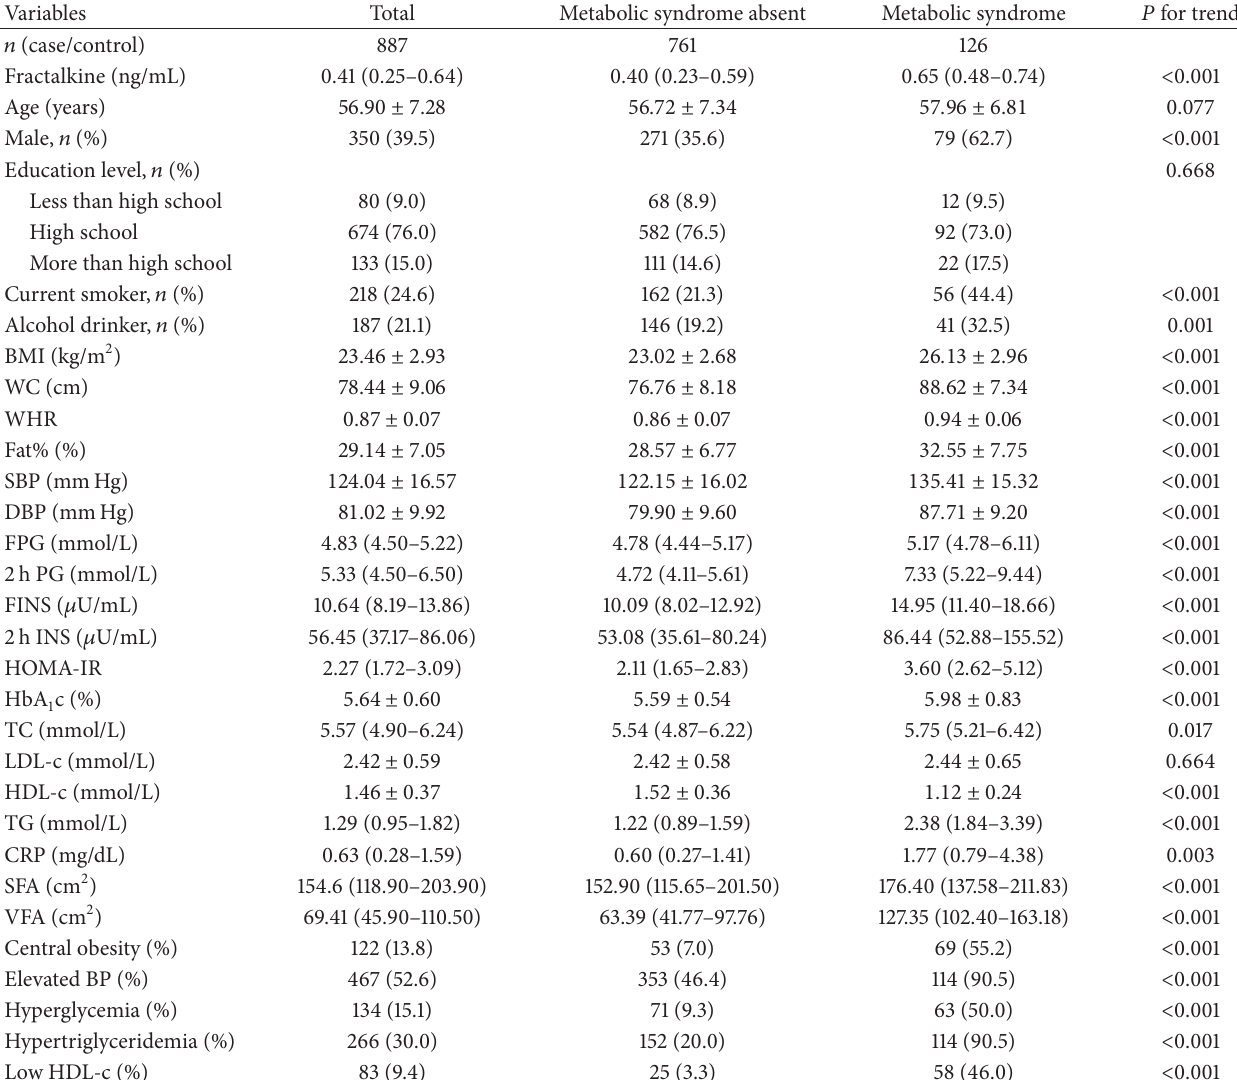
Table 1: Baseline characteristics of participants according to the presence or absence of the MetS ( 𝑛 = 887